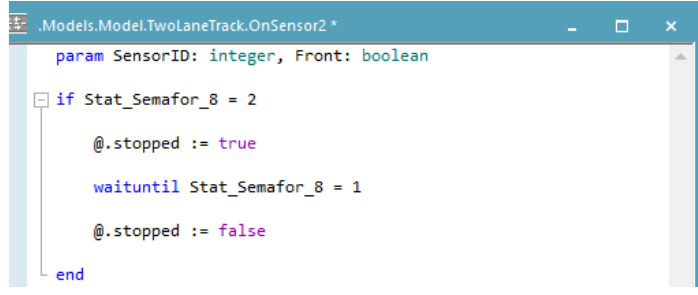
Figure 10. Connector method for stopping and starting a pedestrian on TLS.